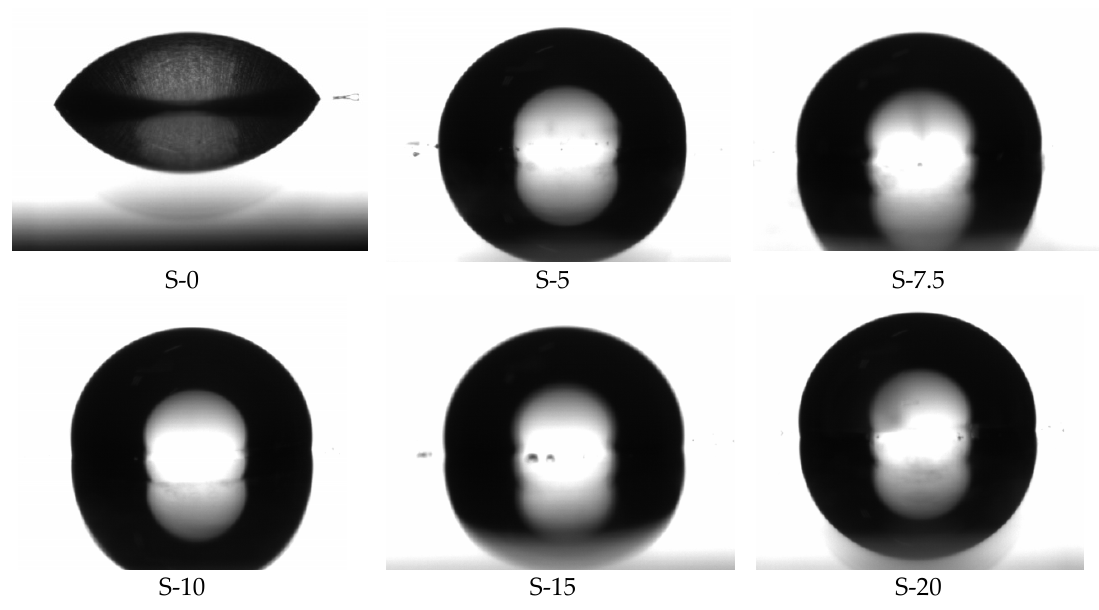
Figure 3. Contact angles of the UV ‐ cured coatings depending on sol–gel content. Table 2. Some of the physical properties of coatings.